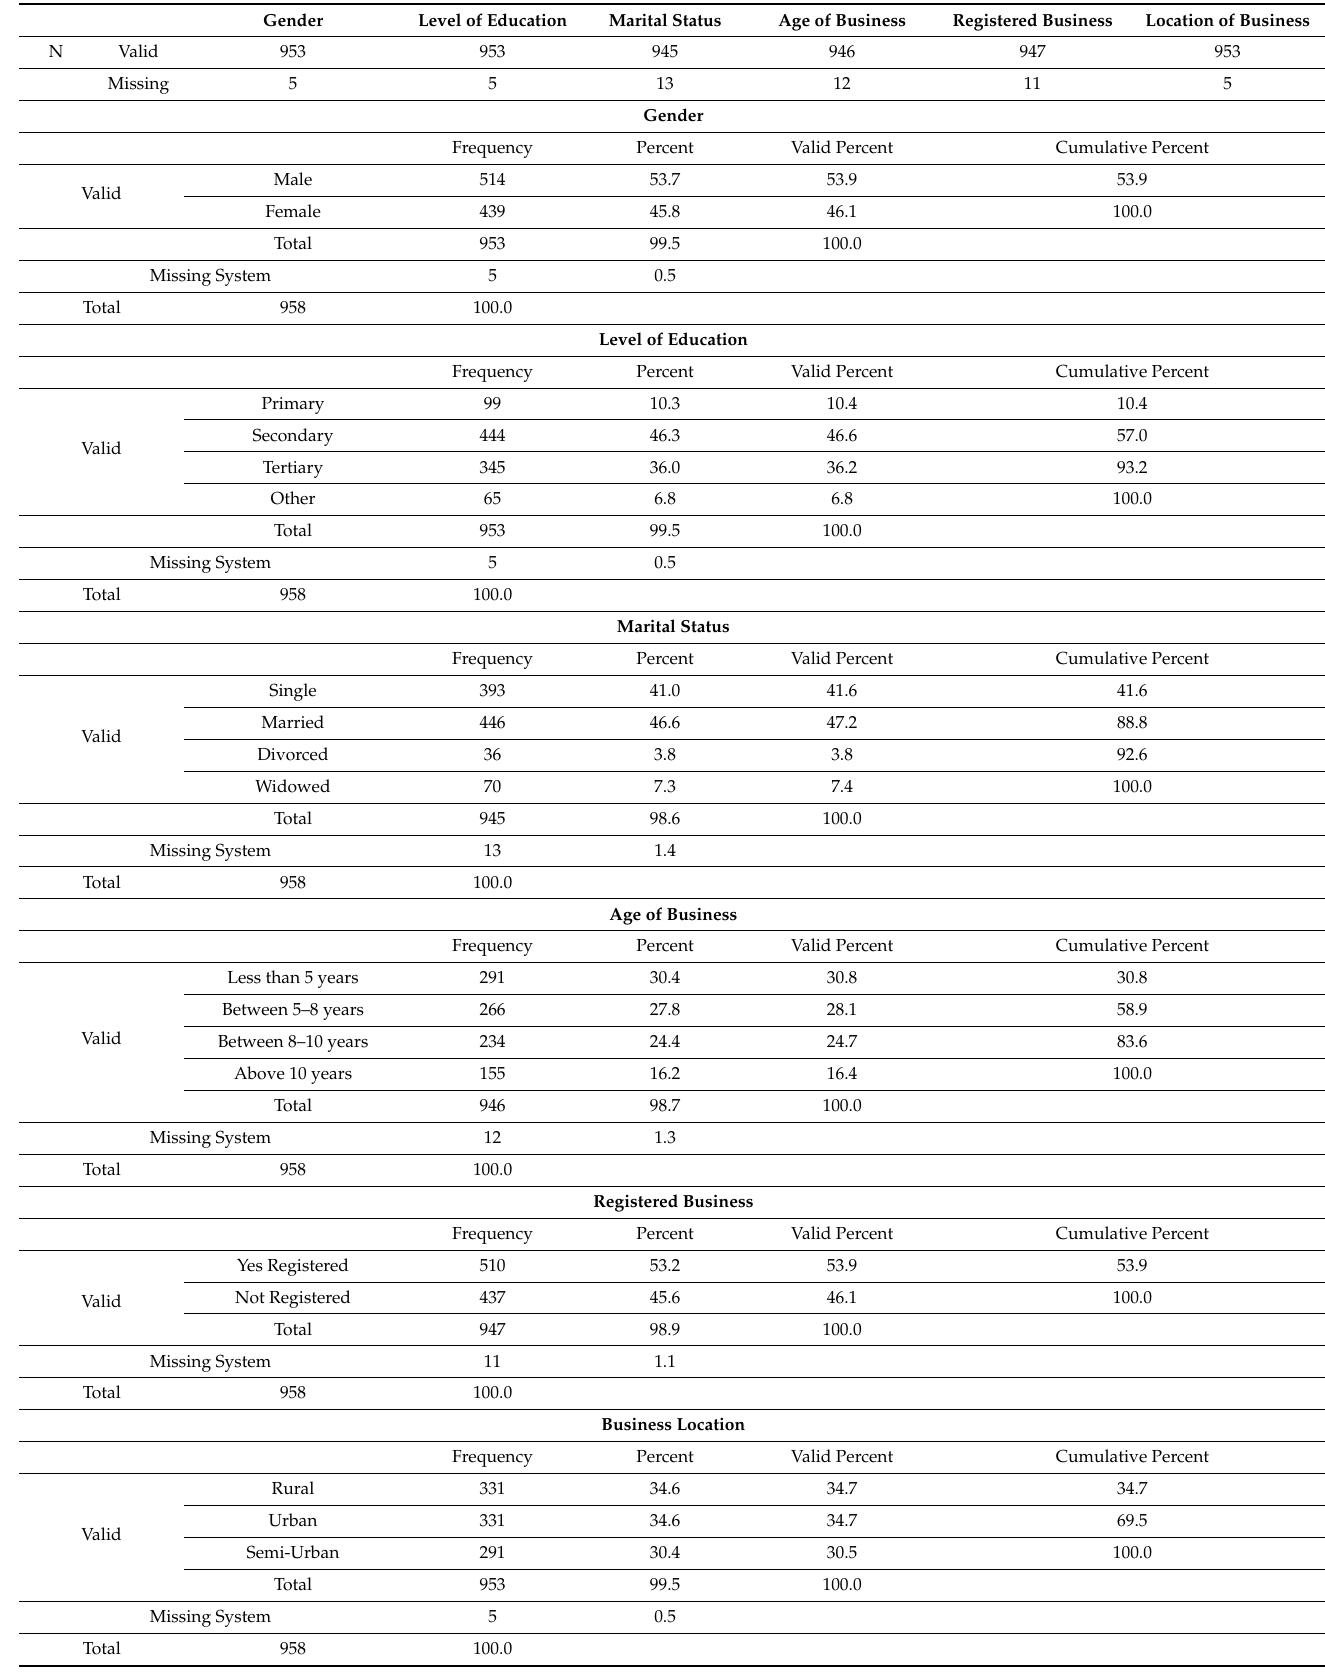
Table 1. Descriptive statistics/demographics of